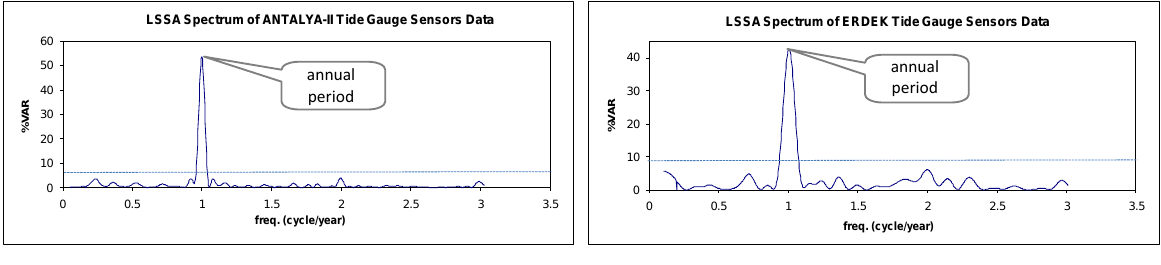
Figure 6. (a,b) LSSA spectra of the sea-level observations and (c,d) LSSA spectra of the observations after the removal of the signal with the highest